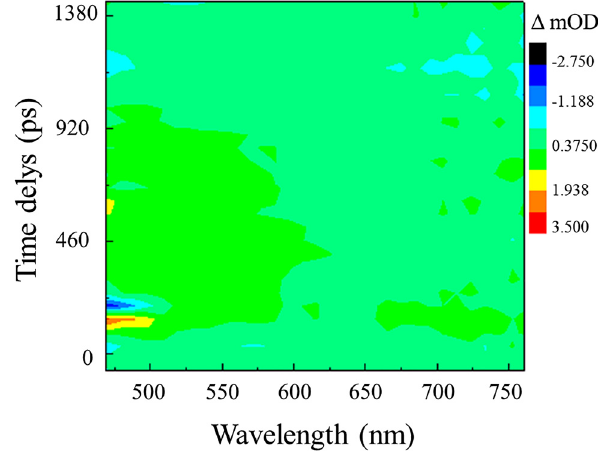
Figure 3: Transient absorption spectroscopy of franckeite. It can be seen that the franckeite make a broadband absorption, especially the multiple ultrafast signals (about 50 – 800 ps, as shown in the yellow,blue,andgreenregions)generatednear500nmwavelength. Color bars indicate changes in optical